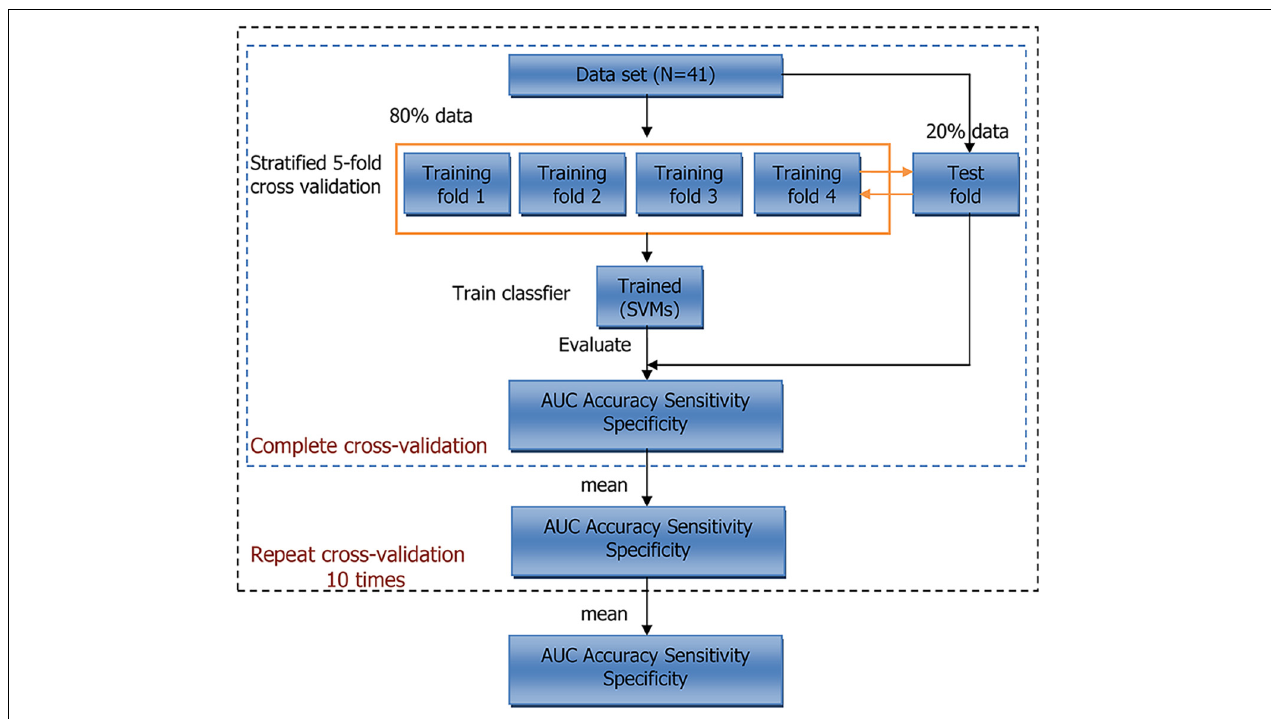
FIGURE 2 | Workflow of 5-fold cross-validation. N indicates sample size. AUC, area under curve; SVMs, support vector machines.